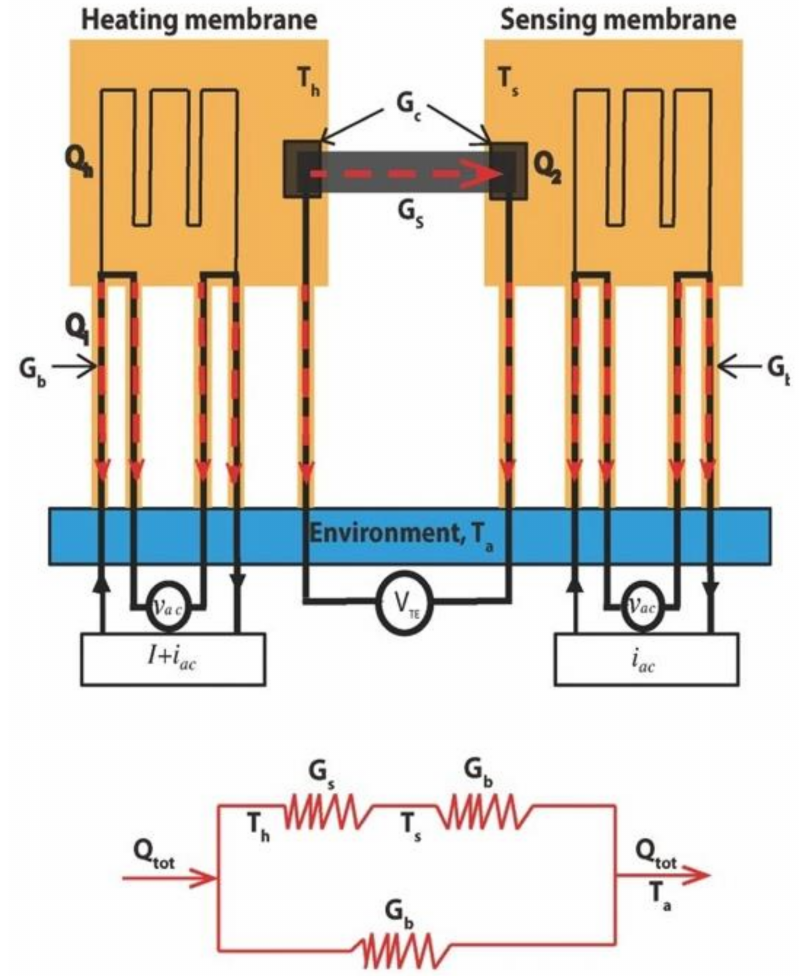
Figure 2. Schematic diagram of microbridge measurement. Reprinted with permission from Ref. [32]. Copyright 2017, John Wiley and